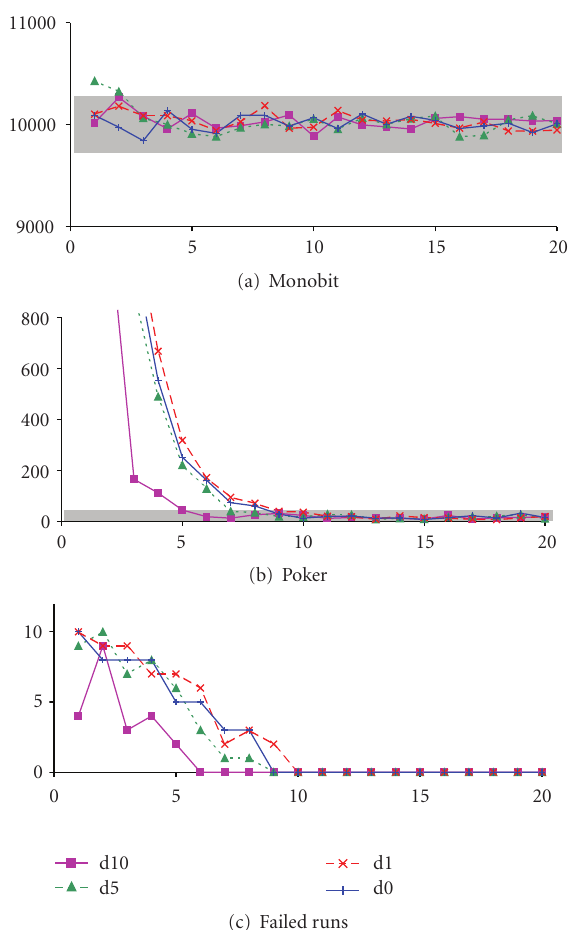
Figure 8: Results of the FIPS 140-2 tests in the Wold’s TRNG architecture simulations while injecting a Gaussian jitter of 30 ps and a varying deterministic